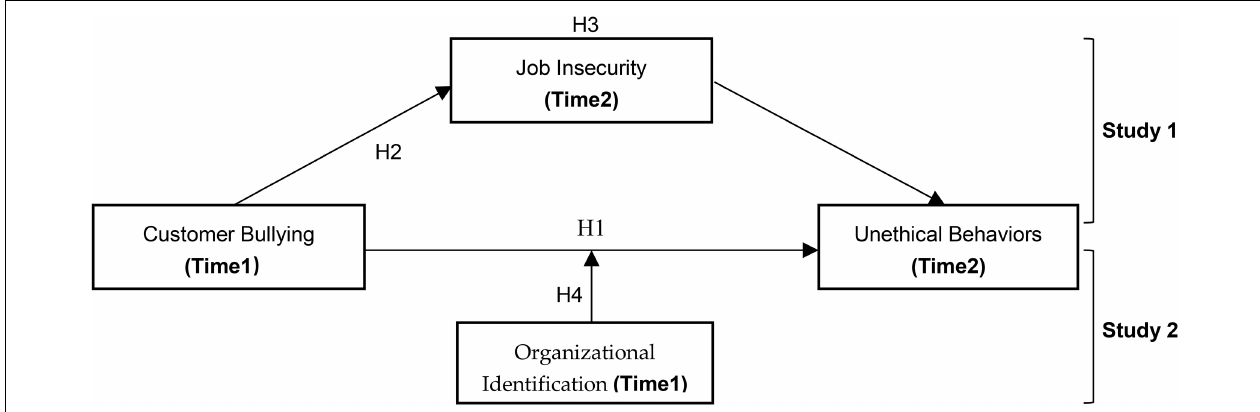
FIGURE 1 | A moderated mediation model where customer bullying triggers unethical behaviors through job insecurity at low levels of organizational identification. Four hypotheses are tested using a two-wave cross-lagged survey (Time 1 and Time 2).